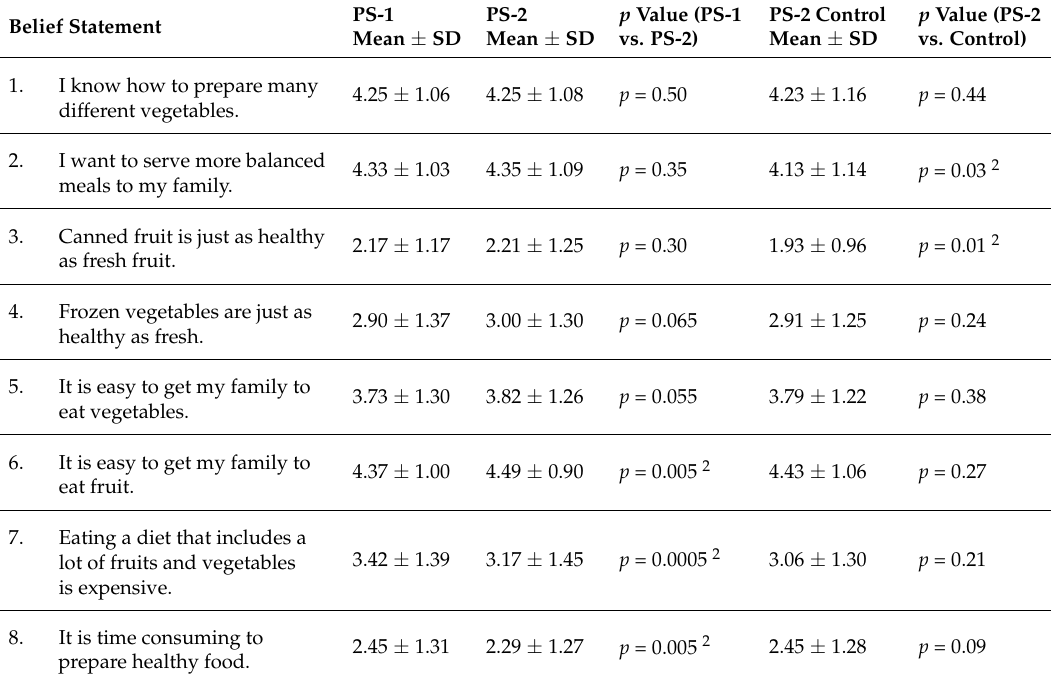
Table 2. Mean responses across all counties to belief statements about fruit and vegetable intake from Phone Survey I (PS-1, n = 1244) and Phone Survey 2 (PS-2, n = 802) 1